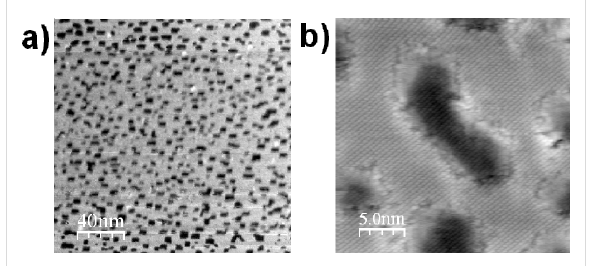
Figure 6: (a) Large-scale topography image of electron-bombarded KCl showing the characteristic holes ( Δ f = − 12 Hz, A 0 = 5 nm); (b) topography image after deposition of ≈ 0.1 ML MSPS and subsequent annealing ( Δ f = − 24 Hz, A 0 = 3 nm). oriented step edges are visible, which are decorated with a few molecules (black